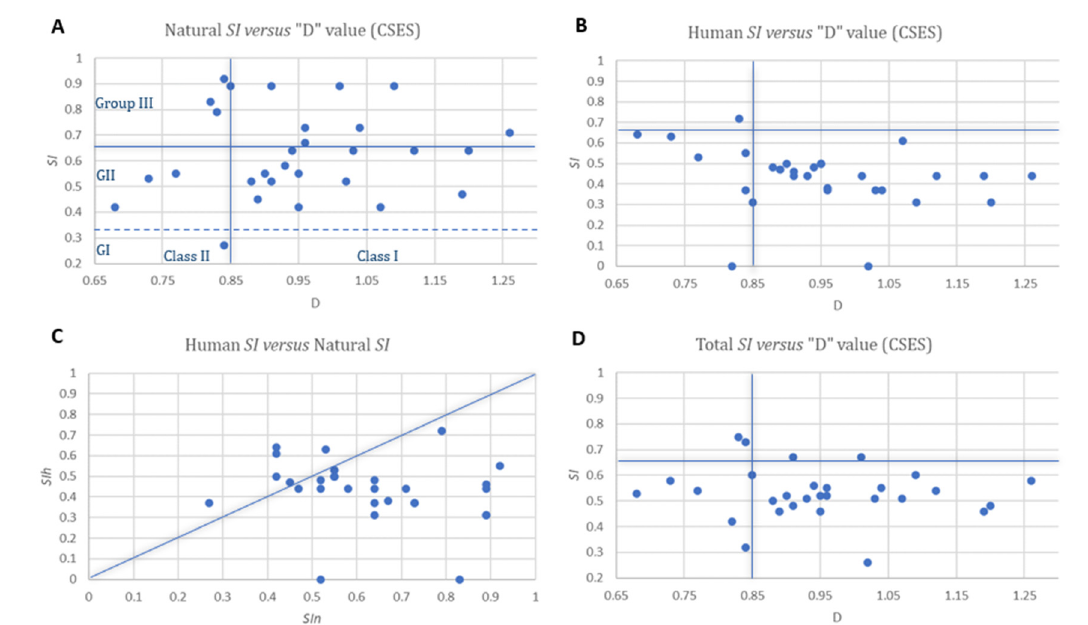
Figure 9. Natural SI versus “D” value (CSES) ( A ); Human SI versus “D” value ( B ); Total SI versus “D” ( C ) and Human SI versus Natural SI ( D ). Limits have been established according to Class I (D ≥ 0.85, CSES) and Group III ( SI ≥ 0.66).